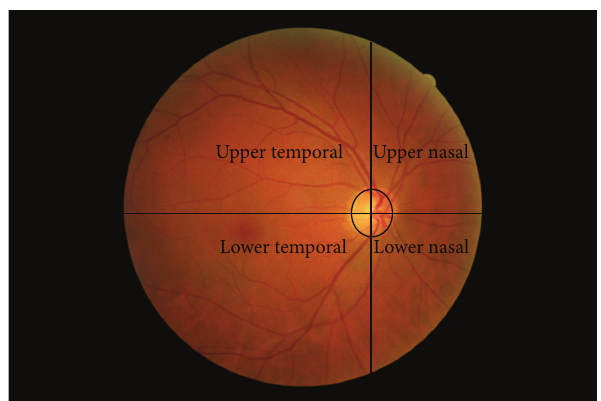
Figure 3: Division of fundus images into four quadrants centered at the optic